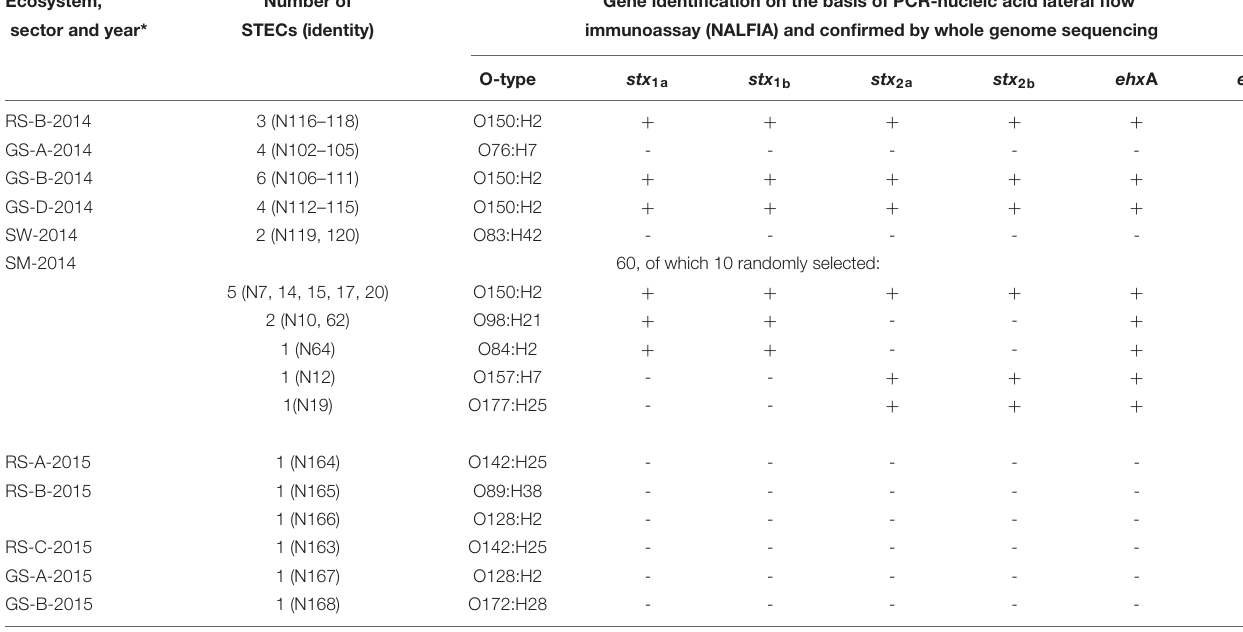
TABLE 2 | Identities and presence of virulence genes in Shiga toxin-producing Escherichia coli (STECs) isolated from different ecosystems over 2 years from the Nijkerk cattle farm. Ecosystem, Number of Gene identification on the basis of PCR-nucleic acid lateral flow sector and year* STECs (identity) immunoassay (NALFIA) and confirmed by whole genome